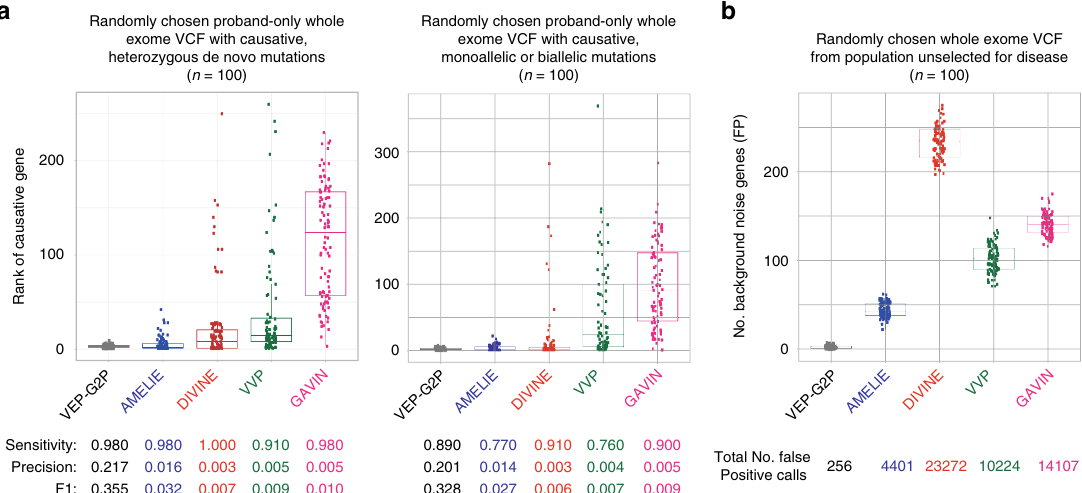
Fig. 4 Comparison of VEP-G2P to existing tools. a Comparison for 100 random DDD samples with dominant de novo sample (left panel) and 100 random DDD recessive samples (right panel). b Comparison for 100 unaffected Generation Scotland (GS) samples. Each dot represents the rank of the causative gene in the output of the tools, where rank of 1 indicates the causative gene is at the top of the list reported by the tool; boxplots show the median (centre line), the fi rst and third quartiles (box bounds), whiskers represent 1.5 ∗ interquartile range from the fi rst/third quartiles. F1 = 2 ∗ ((precision ∗